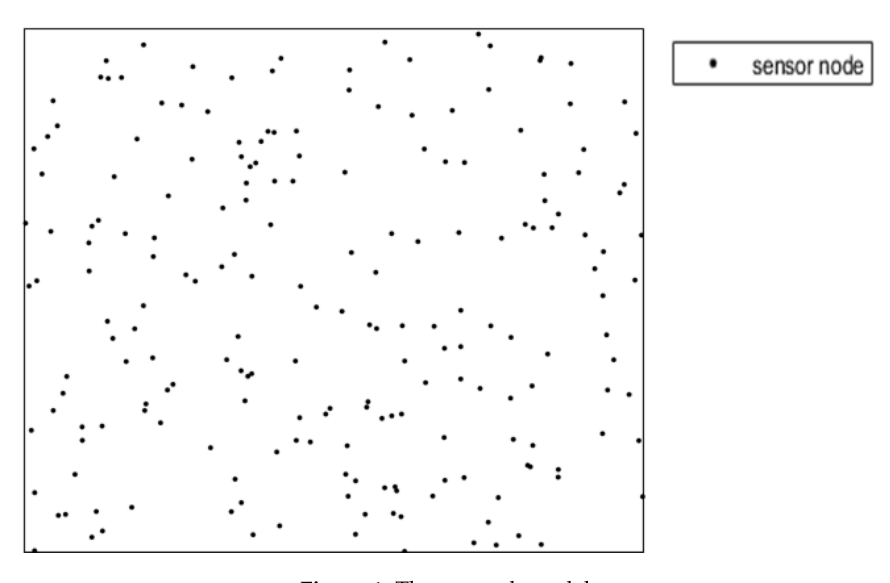
Figure 1. The network model.